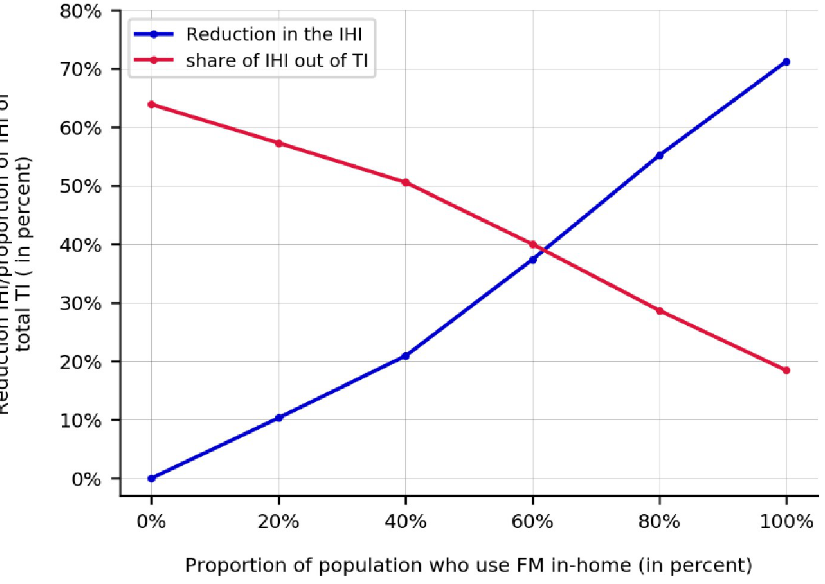
Fig 2. The influence of wearing facemask in-home on the reduction in in-home infections as well as the share of in-home infections over all the infections in the system. Note: while facemask use in-home can reduce the infections in the households by 71.2%, the IHI share is reduced at most by